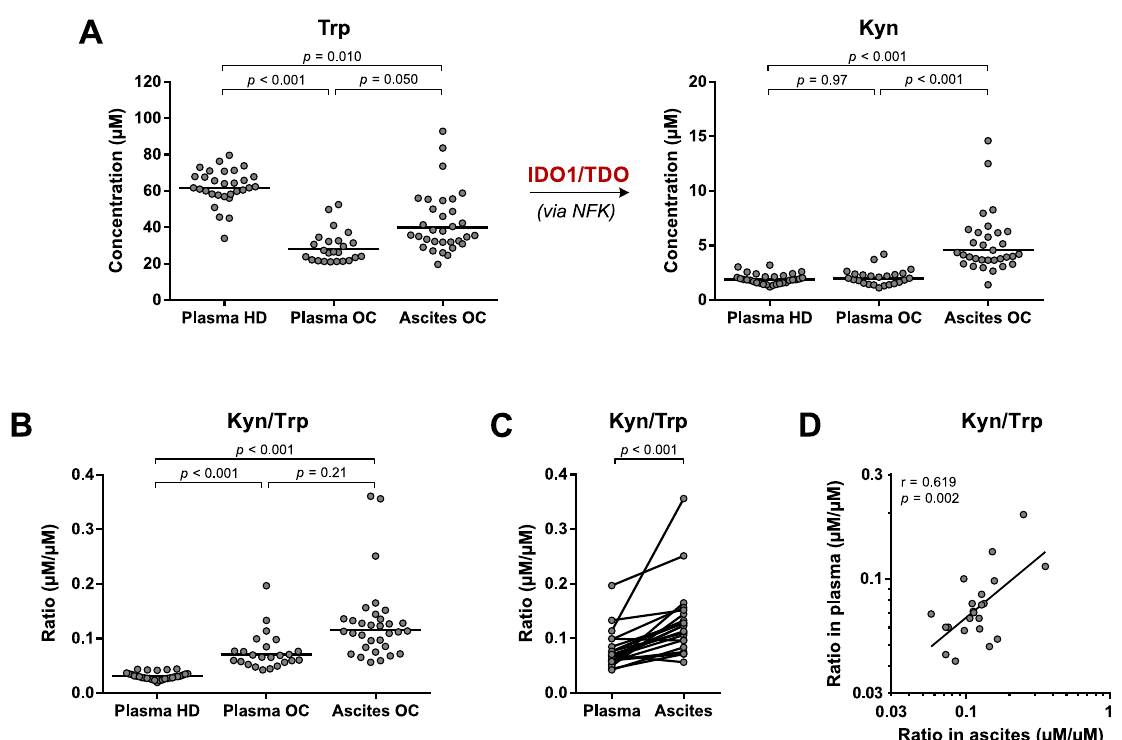
Figure 4. Trp metabolism towards Kyn formation in high-grade serous ovarian cancer patients and healthy donors. ( A ) Trp and Kyn levels and ( B ) Kyn/Trp ratios as indirect measures of IDO1/TDO enzymatic activity in plasma of healthy donors (HD) ( n = 30) and plasma and ascites of ovarian cancer patients (OC) ( n = 24 and 32, respectively, with n = 22 overlapping patients). Horizontal lines indicate geometric means. Repeated unpaired, two-tailed Kruskal–Wallis tests yielded significant results for comparison of Trp levels, Kyn levels and Kyn/Trp ratios between the groups ( p < 0.001 for all). Results of Dunn’s post hoc test are indicated in the graphs. ( C ) Comparison and ( D ) correlation of Kyn/Trp ratios in paired plasma and ascites samples of ovarian cancer patients ( n = 22). Results of a paired, two-tailed Student’s t -test and Pearson’s correlation analysis, both performed with log-transformed concentrations, are indicated in the graphs. IDO1: indoleamine 2,3-dioxygenase; Kyn: L -kynurenine; NFK: N -formylkynurenine; r: Pearson’s correlation coefficient; TDO: tryptophan 2,3-dioxygenase; Trp: L